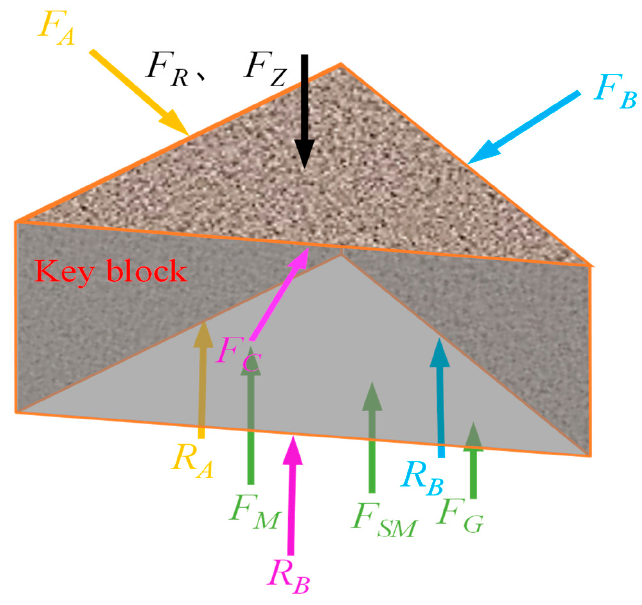
Figure 5. Mechanical analysis of the lateral breaking “large structure”.